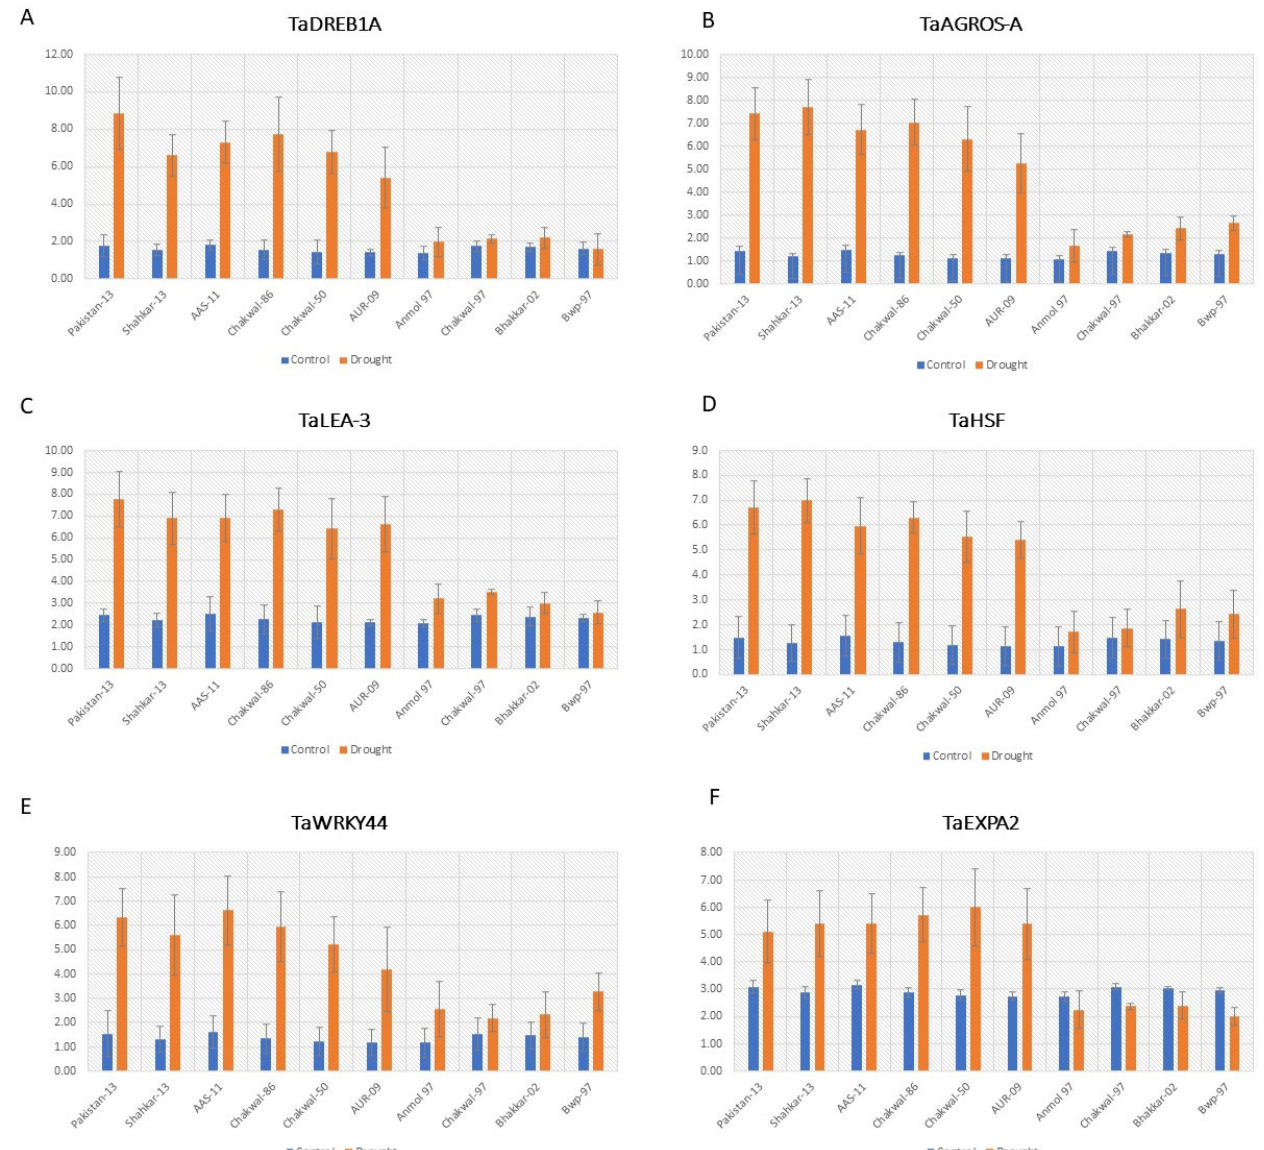
Figure 5. Relative expression analysis of drought-associated genes in selected wheat genotypes under control and drought stress conditions.